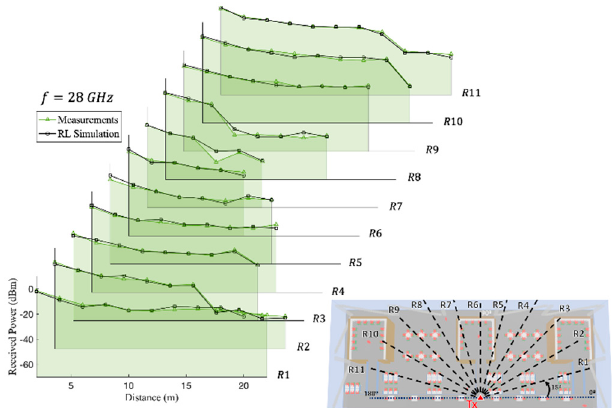
Figure 14. Experimental measurements and 3D-RL simulation comparison at 28 GHz frequency along the different linear radial distributions R 1 , …, R 11 depicted in Figure 8.